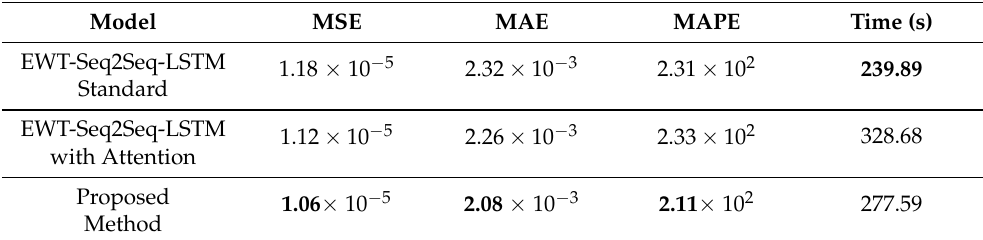
Table 4. Model comparison